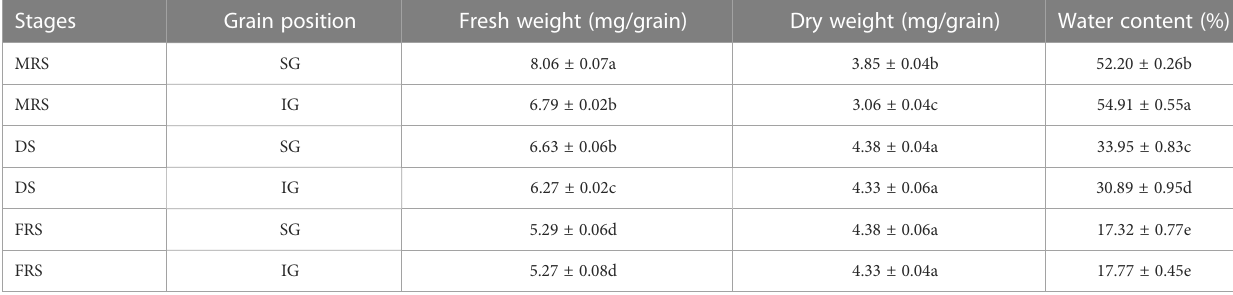
TABLE 1 The information of seed dry weight, fresh weight and water content at MRS, DS, and FRS.